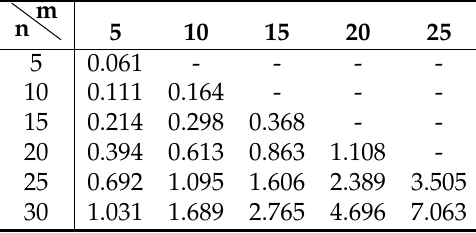
Table A4. Total solution time using Legendre polynomials in seconds for Problem #1.